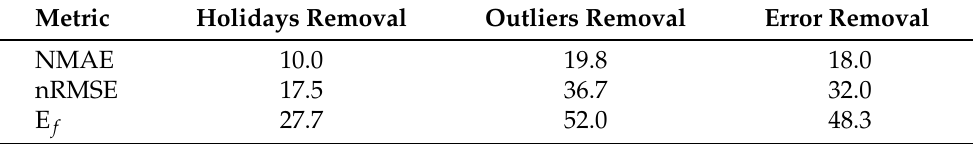
Table 4. Load forecast increase of accuracy with respect to the benchmark (no cleaning